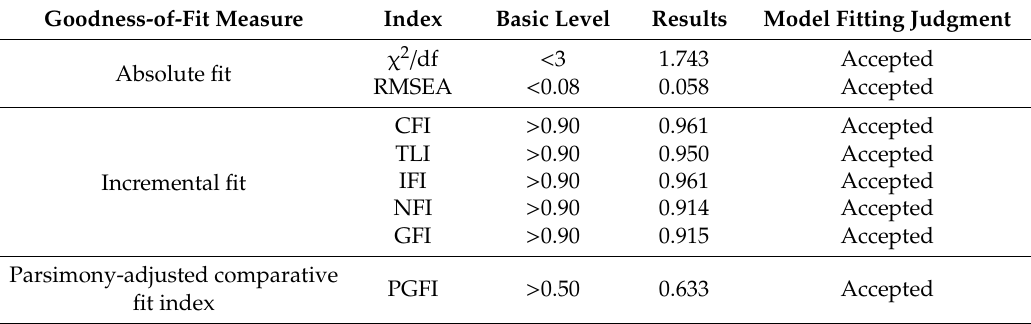
Figure 2. Confirmatory factory analysis (CFA) model. Table 4. Goodness-of-fit measures of CFA model.